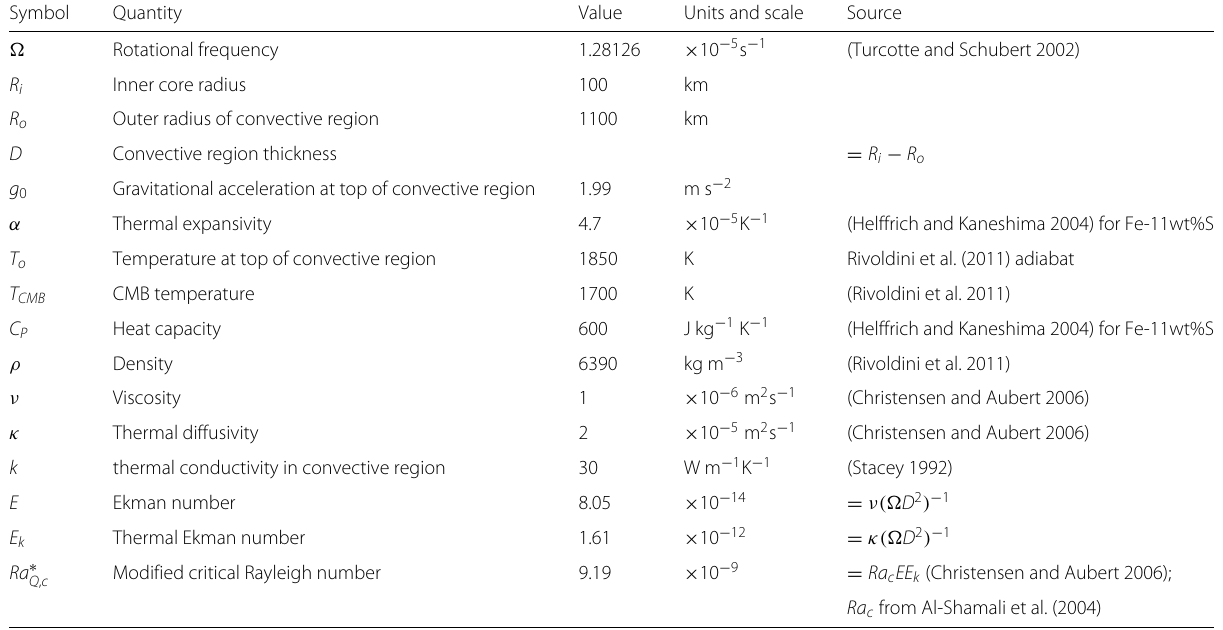
Table 2 Mars thermophysical properties relevant for dynamo